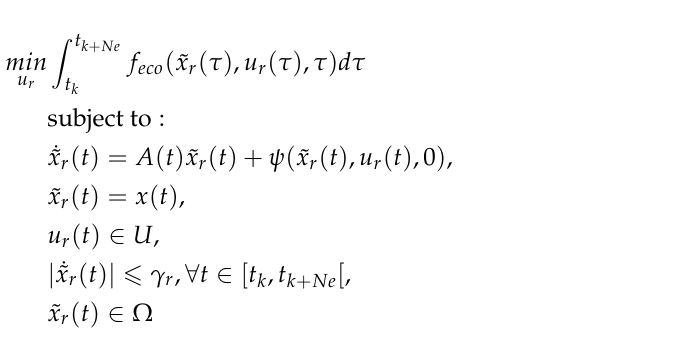
where N e is the prediction horizon, f eco ( ˜ x r ( τ ) , u r ( τ ) , τ ) is the time-dependent economic cost function, ˜ x r ( t ) is the predicted trajectory of the system with the manipulated input u r ( t ) computed by the economic NMPC, and x ( t ) is the state measurement obtained at time t k .